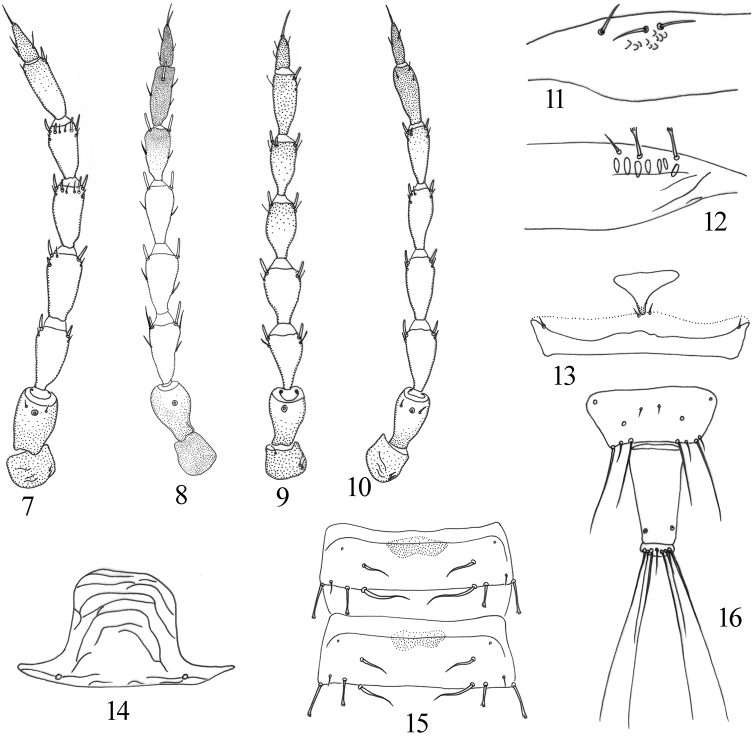
Podothrips species. 7–10 Antenna 7P.
femoralis sp. nov. 8P.
odonaspicola9P.
sasacola10P.
semiflavus. 11, 12 Base of forewing 11P.
sasacola12P.
femoralis sp. nov. Some important features of P.
femoralis sp. nov. 13 mesopresternum 14 Pelta 15 abdominal tergites IV–V 16 abdominal tergites IX–X.